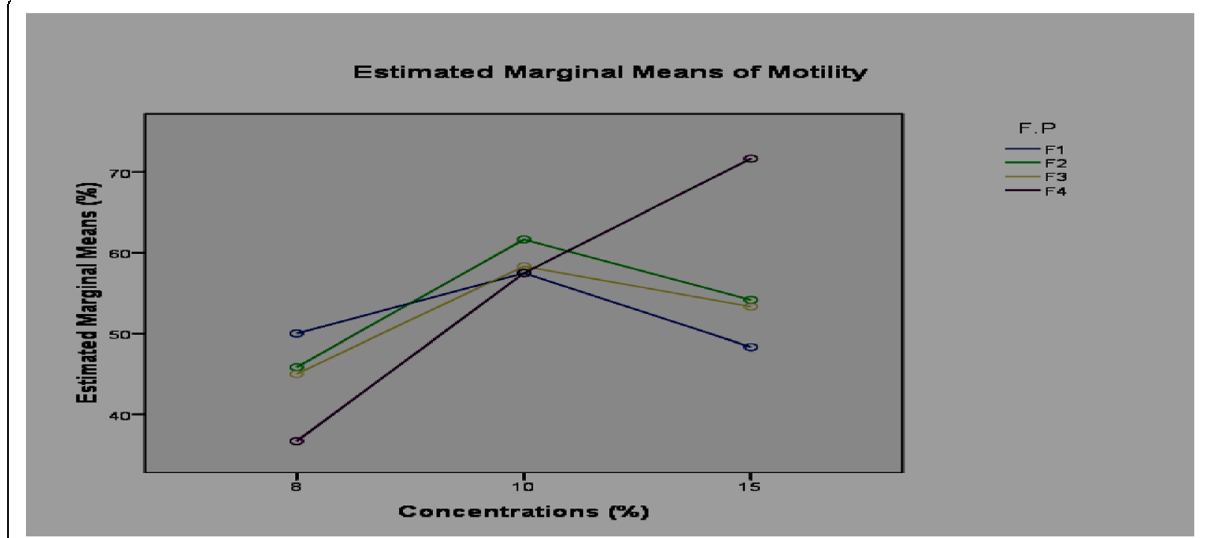
Fig. 2 Effect of different freezing protocols on motility of post thawed rooster semen on different concentrations of